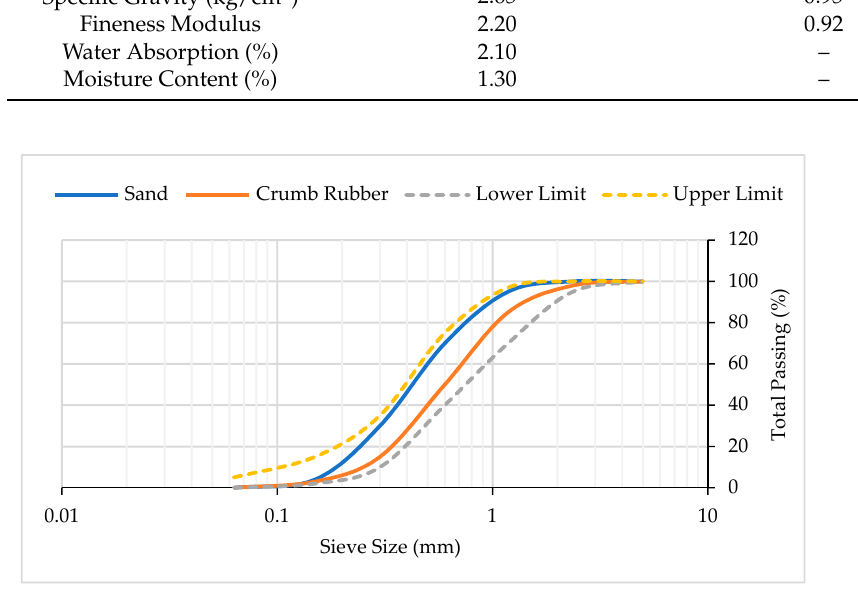
Figure 1. Particle size distribution graph of fine aggregates.